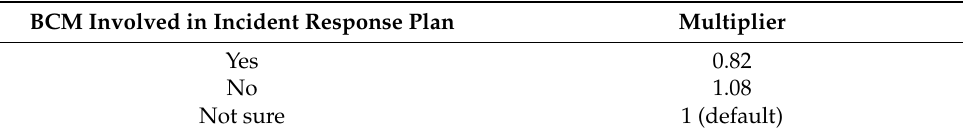
Table 11. Cost factor—F BCM